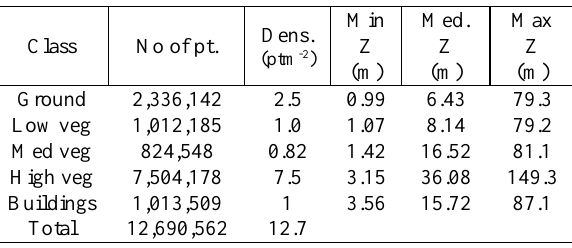
Table 1. LiDAR point statistics used during the experiment The 0.5 m x 0.5 m lattice DTM was produced by dividing the triangulated ground class points